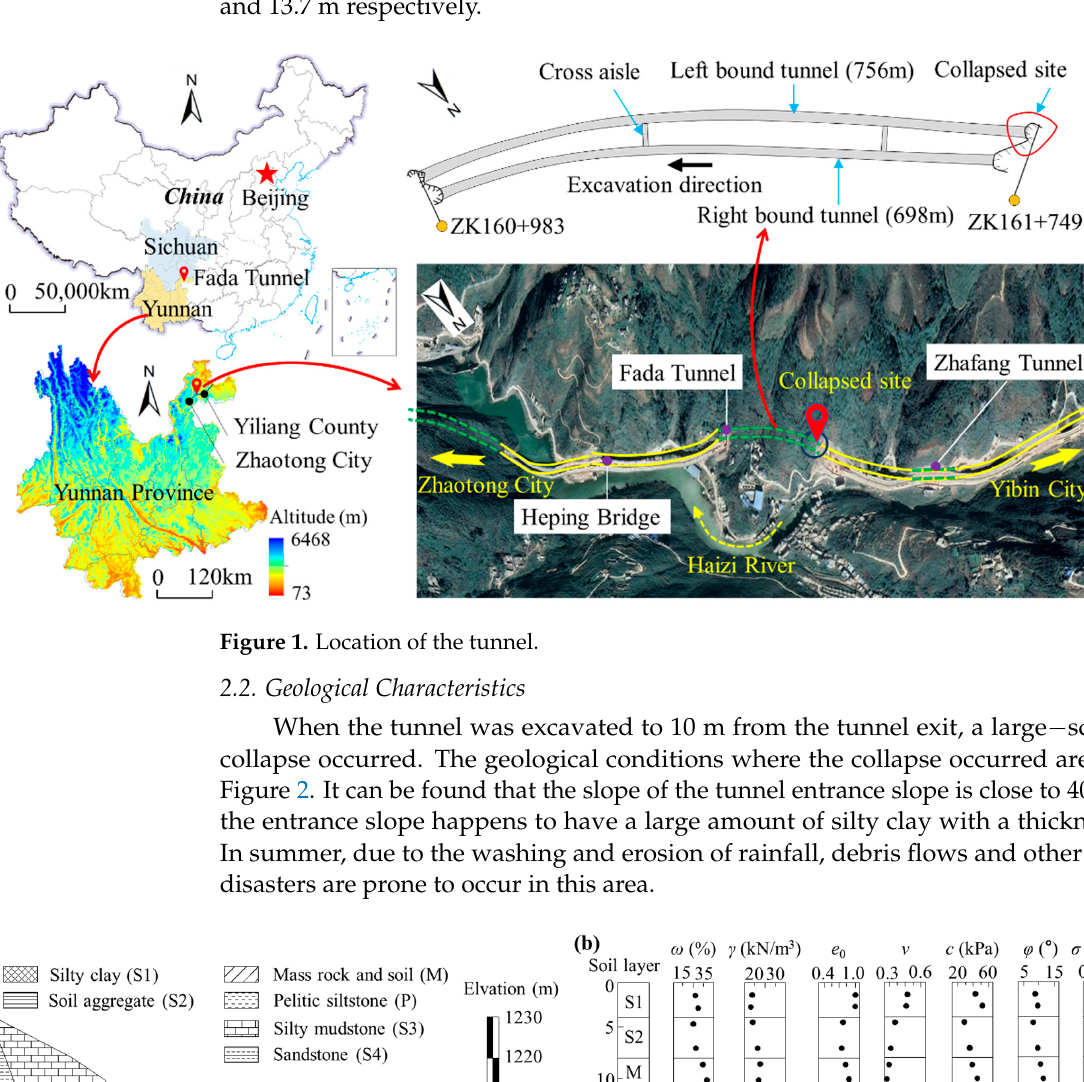
Figure 2. Geological conditions. ( a ) Strata at the collapsed site; ( b ) measured soil parameter profiles.